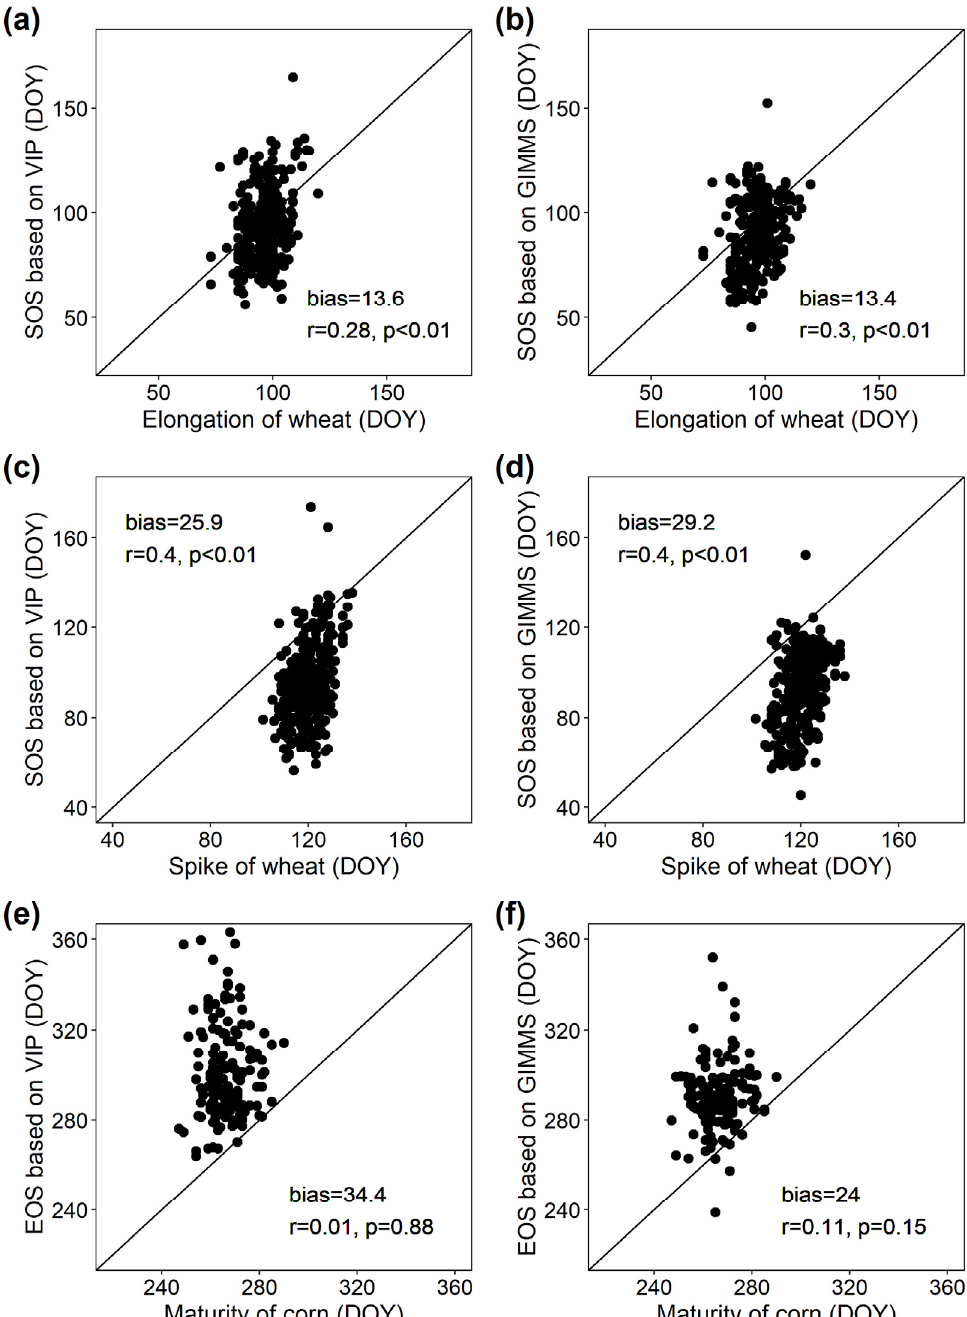
Figure 3. Comparison of remotely based SOS/EOS and ground observations. ( a )/( b ) SOS derived from VIP/GIMMS vs. the elongation date of wheat; ( c )/( d ) SOS derived from VIP/GIMMS vs. the spike date of wheat; ( e )/( f ) EOS derived from VIP/GIMMS vs. the maturity date of corn. DOY means the day of the year.